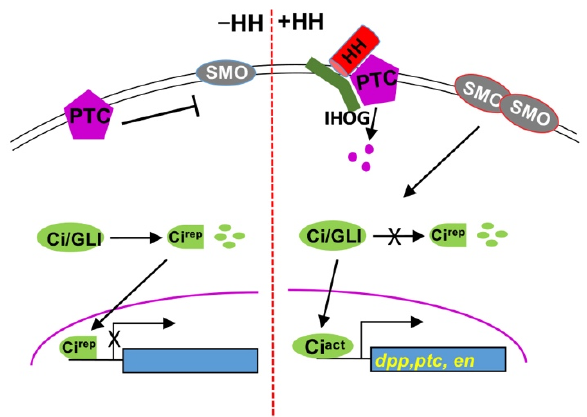
Figure 1. The highly conserved HH signaling pathway. Shown here is a scheme of the HH pathway. ( Left panel ), in the absence of HH, PTC inhibits SMO. Ci/GLI is processed into a truncated repressor form that enters the nucleus to block target gene expression. ( Right panel ), the presence of HH relieves the inhibition of PTC on SMO, leading to dimmerization and cell surface accumulation of SMO. Upon Hh stimulation, full-length Ci is activated to turn on target gene expression.